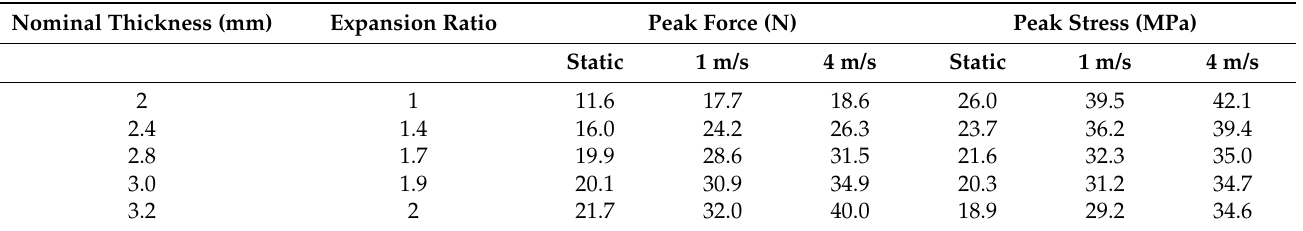
Table 2. Results from bending tests at different speeds on specimens with different expansion ratios. Values are averaged on three tested